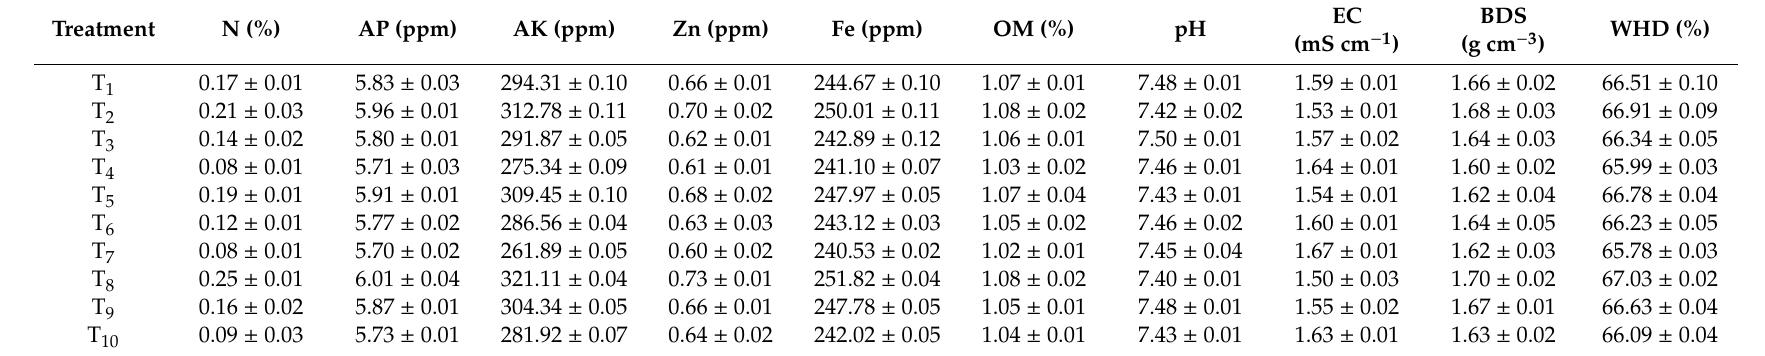
Table 7. Physio-chemical parameters of soil after harvesting of wheat